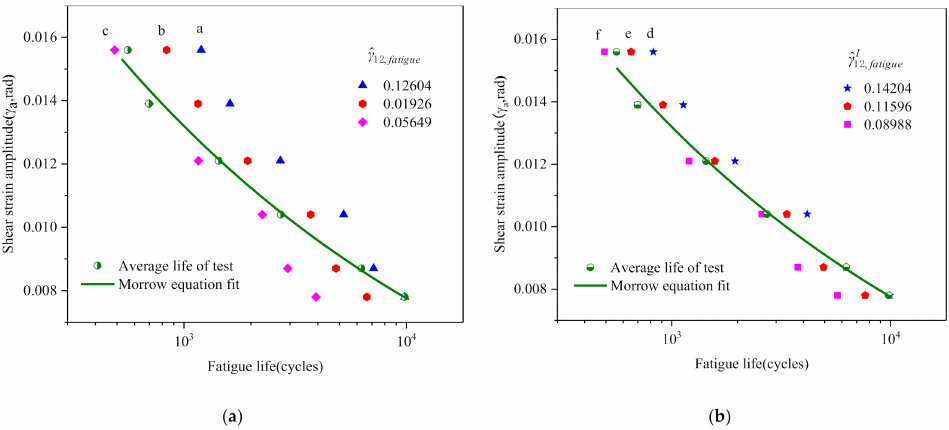
Figure 14. ( a , b ) Predicted life family lines by the maximum, median and minimum values of ˆ γ